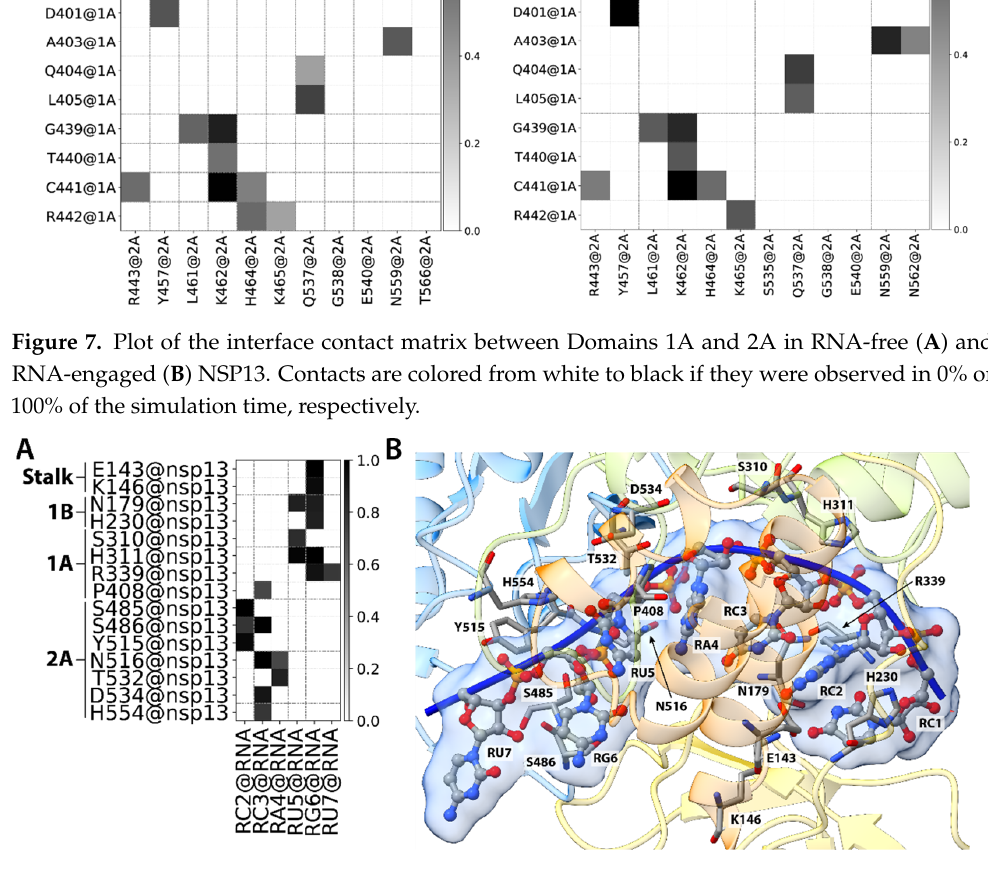
Figure 7. Plot of the interface contact matrix between Domains 1A and 2A in RNA-free ( A ) and RNA-engaged ( B ) NSP13. Contacts are colored from white to black if they were observed in 0% or 100% of the simulation time, respectively.